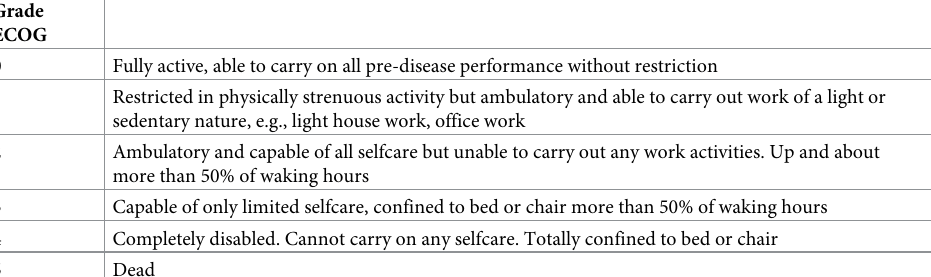
Table 2. Eastern Cooperative Oncology Group (ECOG) performance